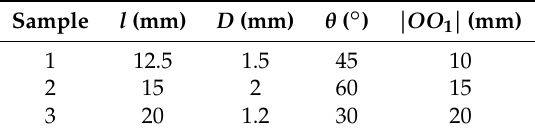
Table 1. Geometrical parameters of different